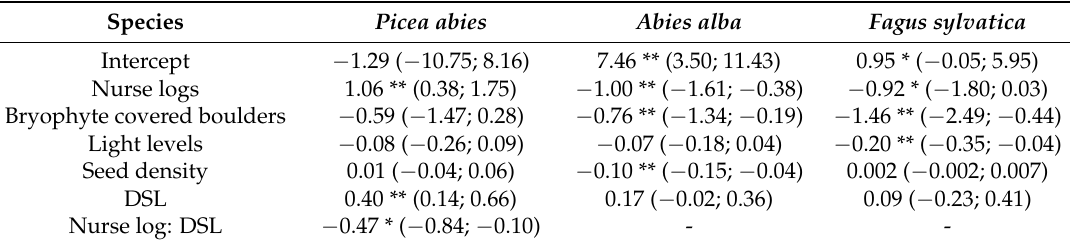
Table 3. Parameter estimates for seedlings of Picea abies , Abies alba and Fagus sylvatica. Species Picea